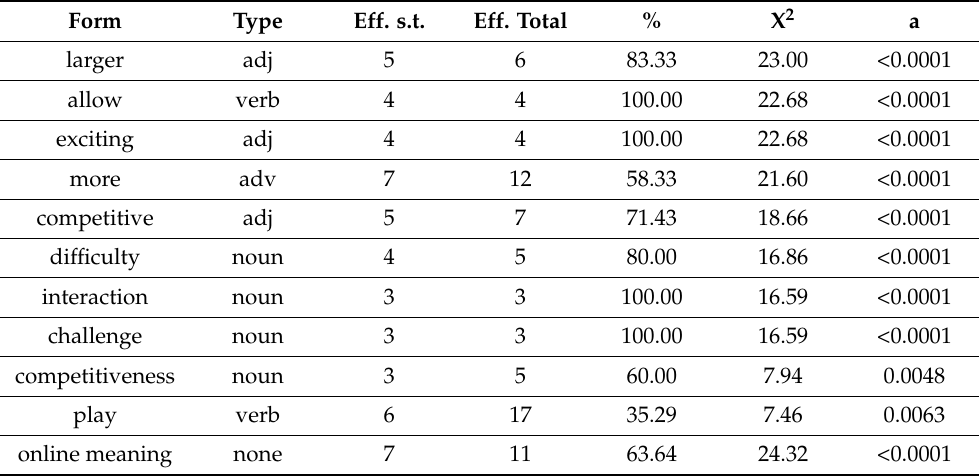
Table 4. More frequent words in class 4: Meaning to play